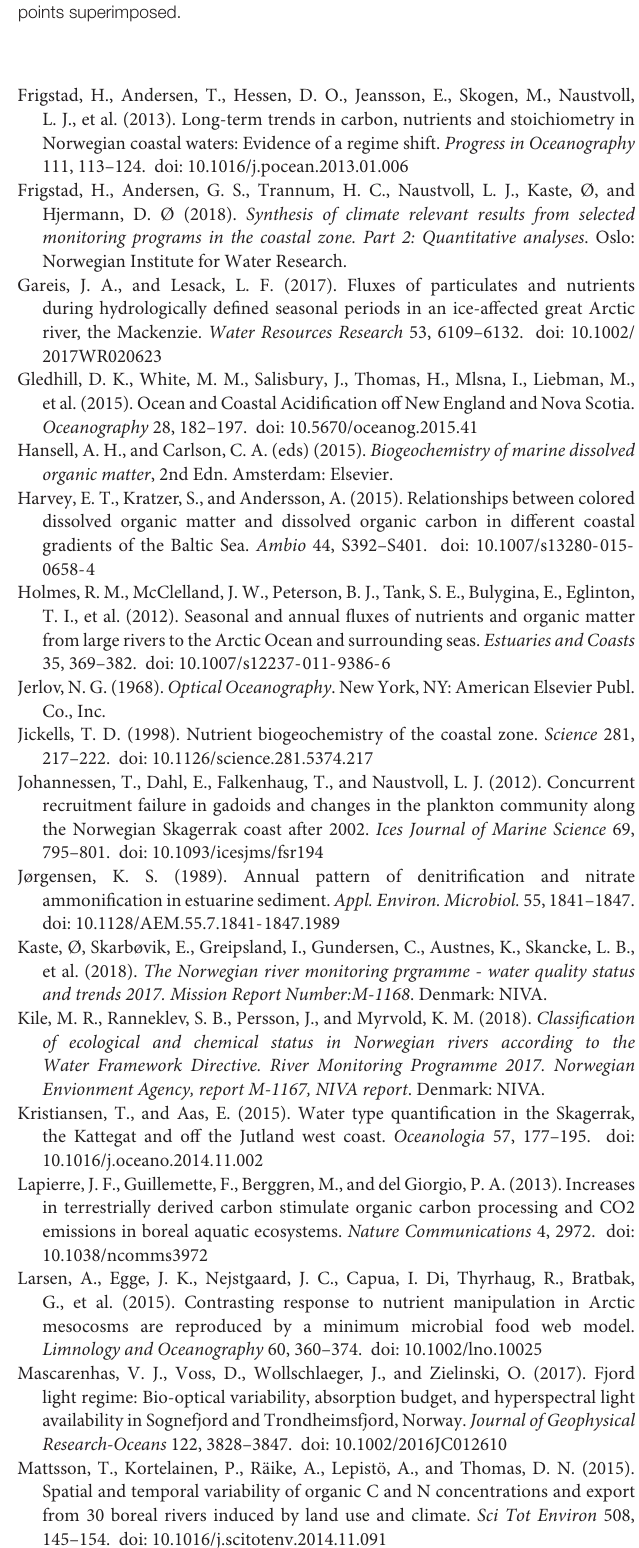
FIGURE S1 | Comparison of salinity measured by underway ship observations (“FerryBox”) at the locations closest to the coastal stations (black dots) and CTD measured salinity at 5 m depth (red open circles) at the Malangen/northern Norway study site.